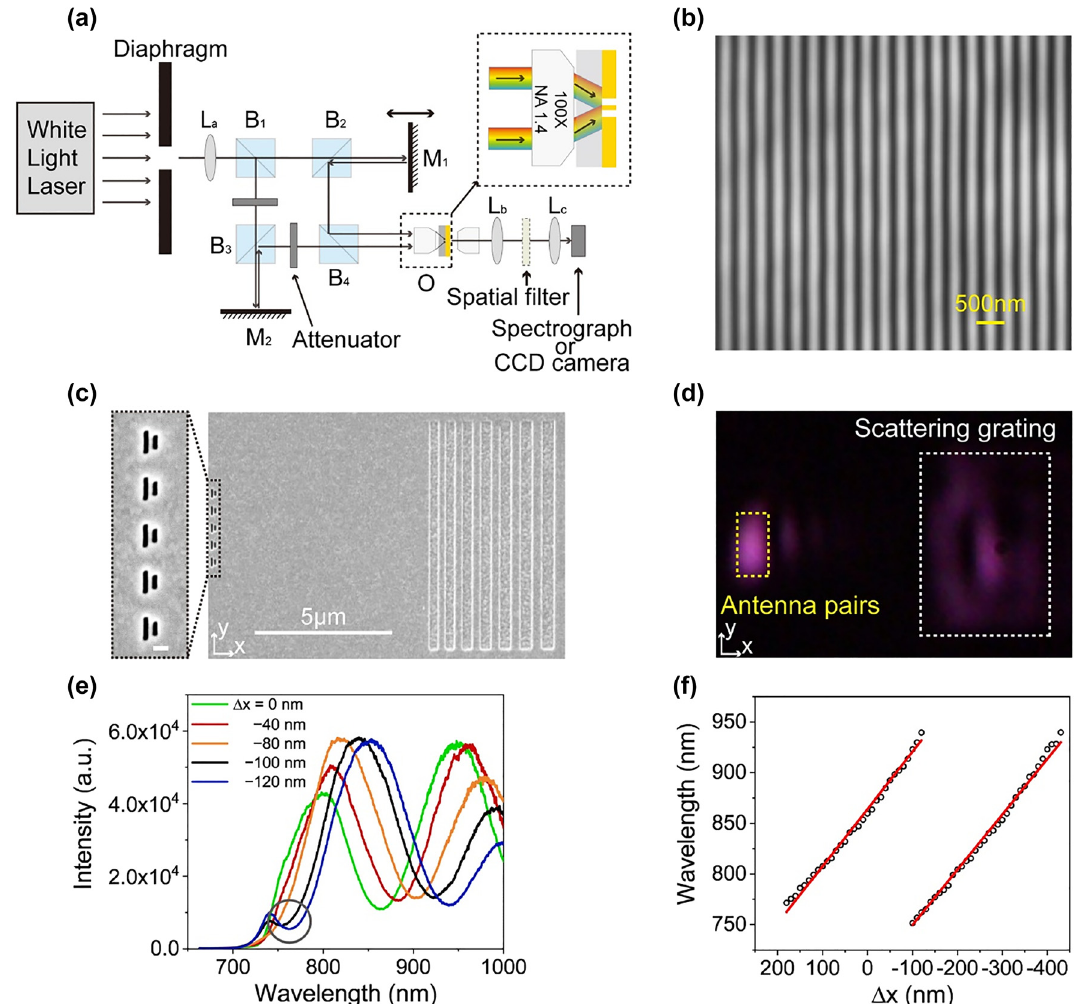
Figure 5: Experimental results of the sensor with a dispersive interference fringe light source. (a)Schematicof theexperimental setup.(b)CCDimageof theinterference fringewhena narrowbandfilterof 810nm is used.(c)SEMimageof fabricated antenna pairs and the scattering grating. Inset: Magni fi ed SEM image of antenna pairs. (d) CCD image of antenna pairs and diffraction grating under the illumination of an x -polarized supercontinuum laser beam. (e) Output spectra for different displacements Δ x . (f) Extinction wavelength versus the displacement Δ x . Red lines represent linear fi